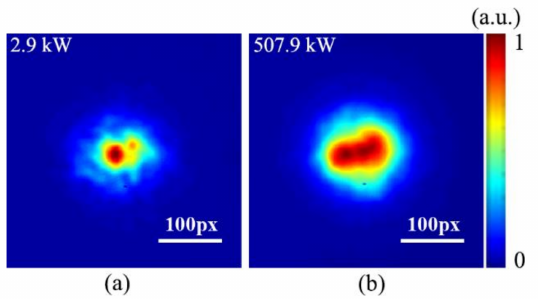
Figure 9. Output beam profiles from a 1 m long uniform MMF at the input peak power of ( a ) 2.9 kW and ( b ) 507.9 kW (scalebar: 100